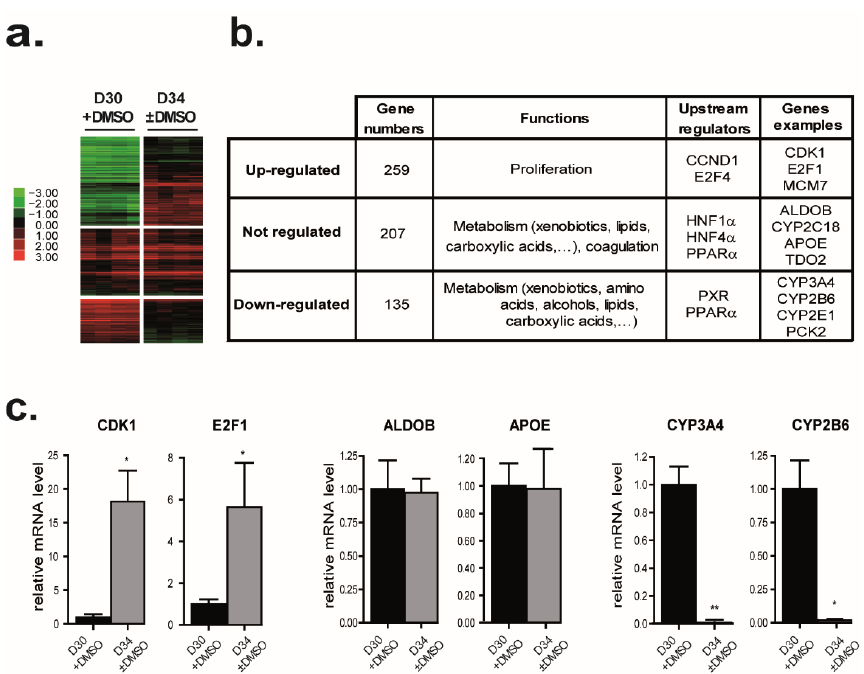
Figure 6. Effects of DMSO removal from the differentiated HepaRG cell culture on gene expressions. DMSO was removed from the HepaRG cell culture medium after the completion of hepatocyte differentiation at D30 + DMSO. Genes were grouped based on the effects of DMSO removal. ( a ) Heat map of the 3 groups of genes: downregulated, upregulated, and not affected by DMSO removal. Green indicates lower expression and red indicates higher expression. ( b ) Top functional categories and upstream transcriptional regulators associated with each gene group highlighted by IPA were summarized in the table. ( c ) Genes whose expressions were downregulated (upper panel), upregu- lated (middle panel), and not affected (lower panel) after the DMSO removal were selected based on the microarray data. The expression of each selected gene was confirmed by real-time RT-PCR. (n = 3). Results are expressed as relative to condition D30 + DMSO, arbitrary set to 1. * p < 0.05, ** p < 0.01.